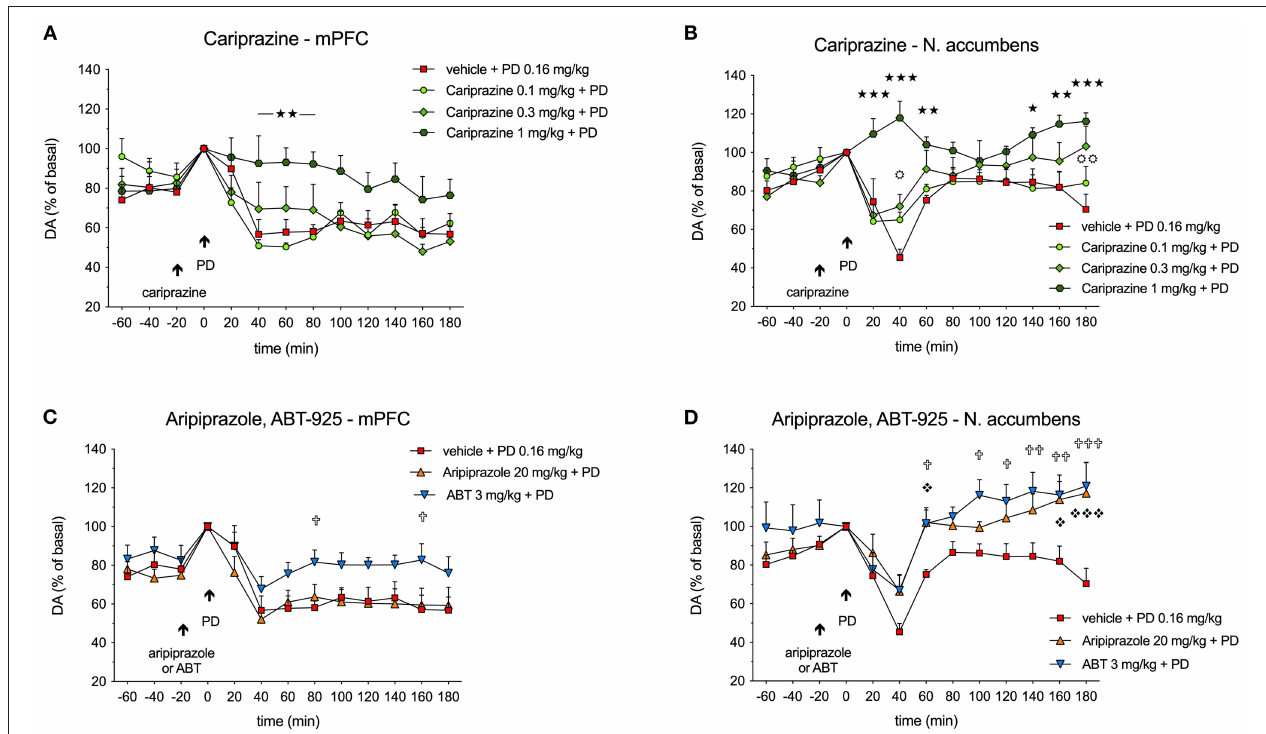
FIGURE 4 | Effects of (A,B) cariprazine, and (C,D) aripiprazole and ABT-925 on ( + )-PD 128907-induced decreases in extracellular DA levels in the mPFC and nAcc shell regions of awake rats; (